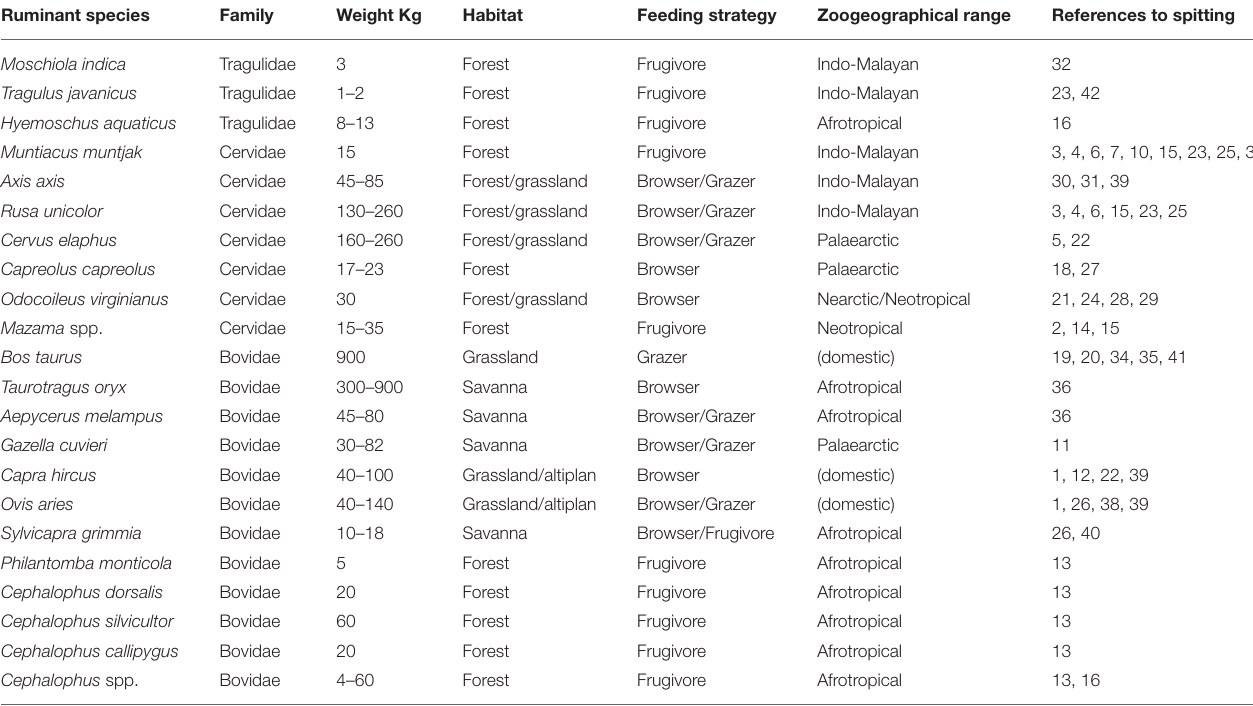
TABLE 2 | Species of ruminants reported as spitters of seeds while ruminating, and some taxonomic, biological, and ecological information about them (from Bodmer, 1990, complemented with Wilson and Mittermeier, 2011). Ruminant